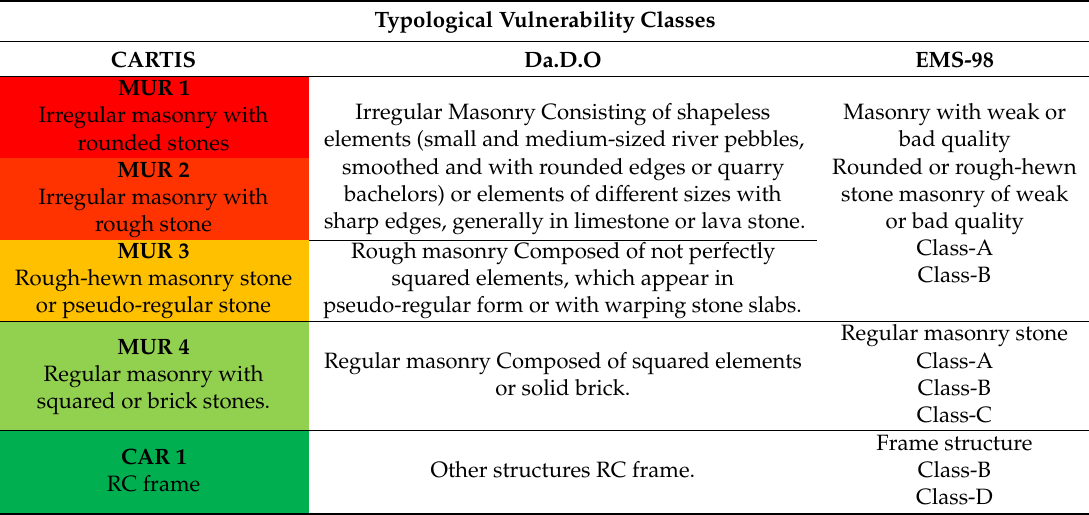
Table 1. Correlation of vulnerability classes among the CARTIS, Da.D.O and EMS-98 methods.